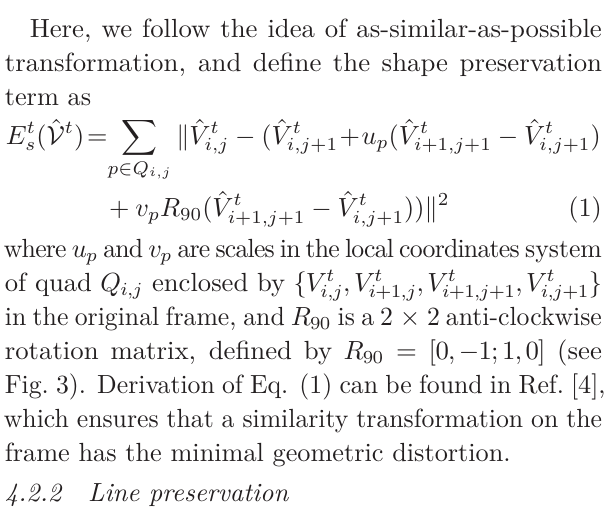
still use { V t i,j } to denote the unified mesh vertices in every frame I t , by which the irregular boundaries are warped to the rectangular shape.